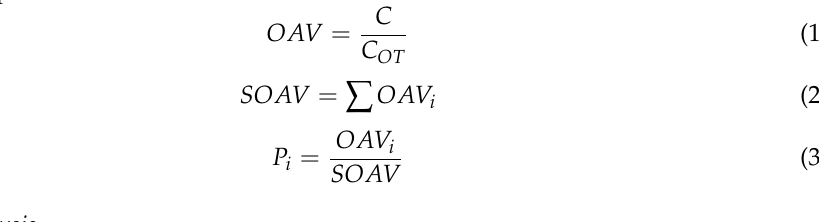
Figure S1: Structure and components of the sealed gas emission chamber; Figure S2: Proportions of the cancer risks of volatile compounds emitted from white emulsion adhesives; Table S1: Odor activity values ( OAVs ) of volatile compounds emitted from white emulsion adhesive; Table S2: Odor activity values ( OAVs ) of volatile compounds emitted from silicone